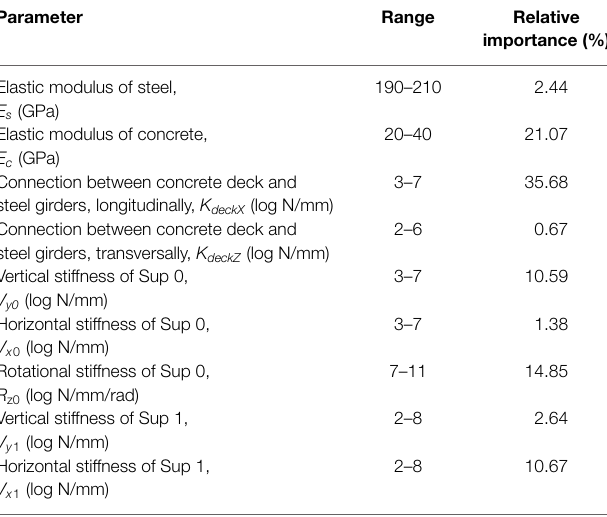
TABLE 3 | Other sources of